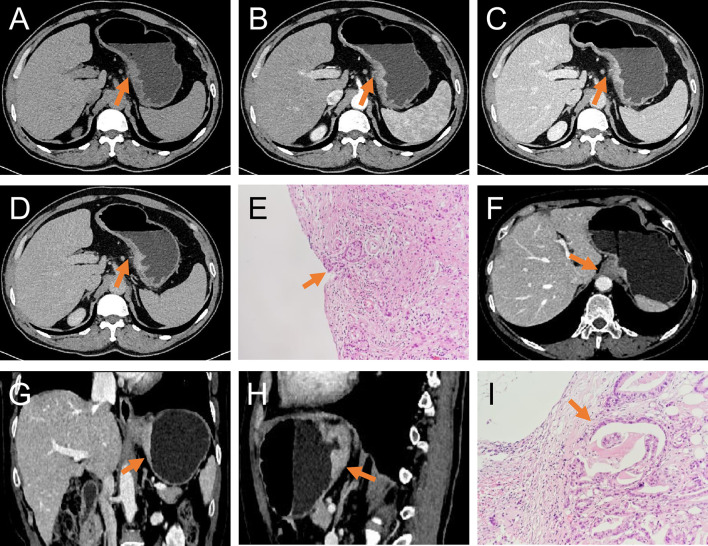
T3 and T4a EGJ adenocarcinoma. (A–D) Axial unenhanced, arterial-phase, venous-phase, and delayed-phase CT images, respectively, of T4a EGJ adenocarcinoma with a nodular shape of the serous surface and infiltration of surrounding fat (arrows). (E) The histopathological analysis under light microscope showed that the tumor invaded the serosa (arrows). (F–H) Axial, coronal, and sagittal venous-phase CT images of T3 EGJ adenocarcinoma with a smooth serous surface (arrows). (I) The histopathological analysis under the light microscope showed that the tumor invaded the subserosal connective tissue (arrows).